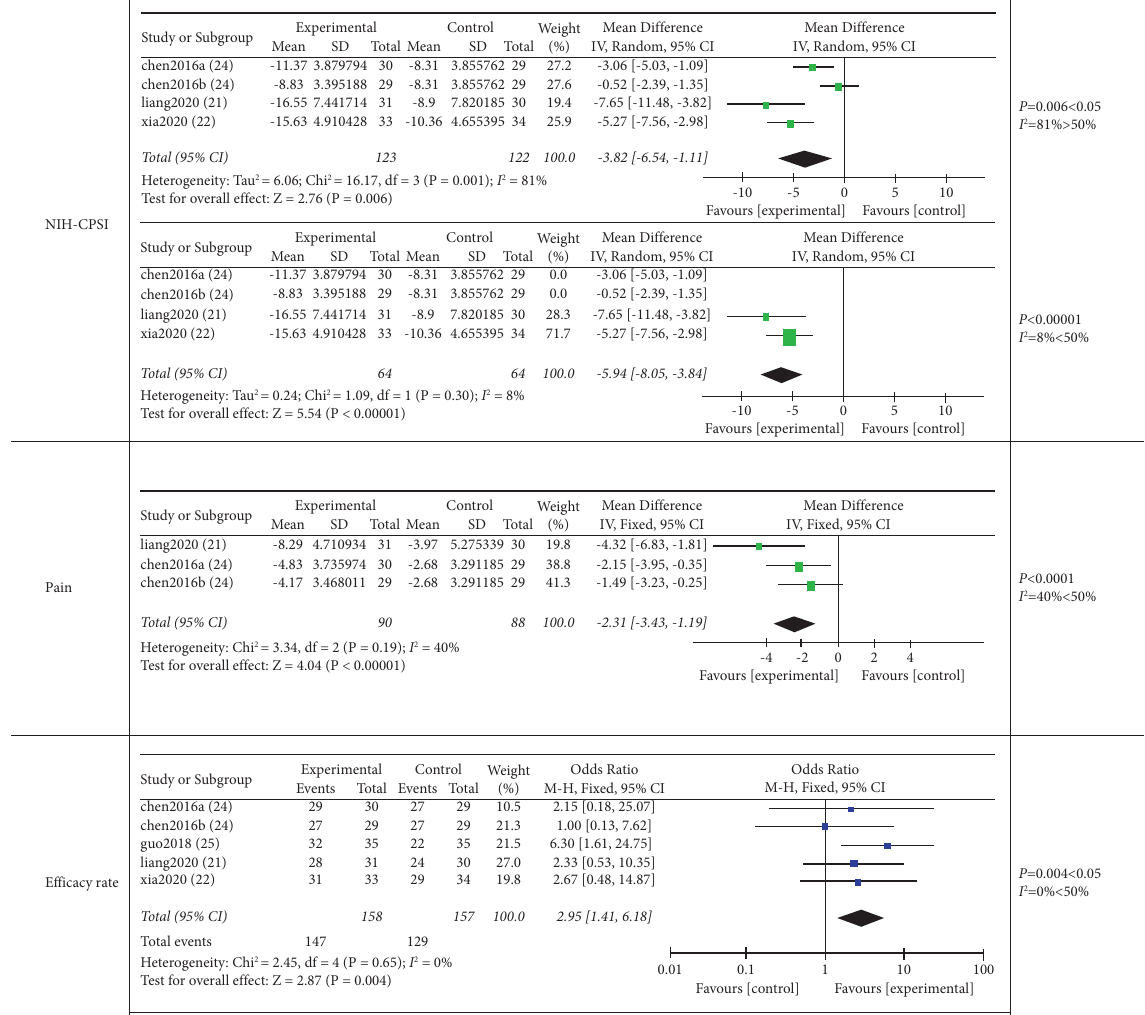
Figure 6: Meta-analysis on comparison of acupuncture verse western medicine in NIH-CPSI, pain, and efcacy